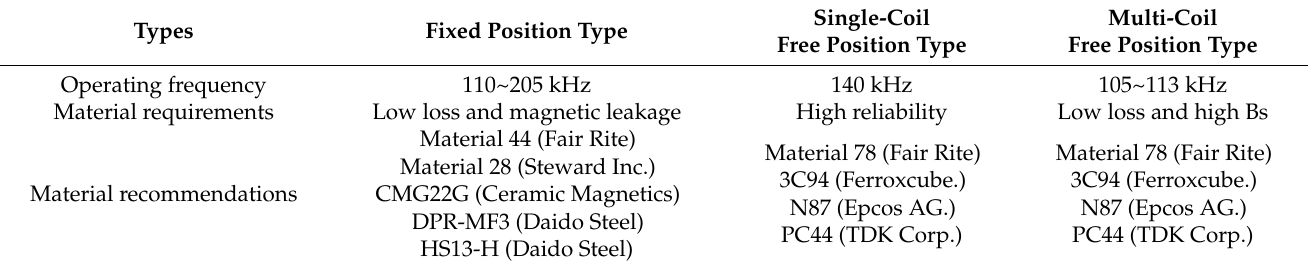
Table 7. Requirements and recommends of magnetic materials for the transmitter in Qi